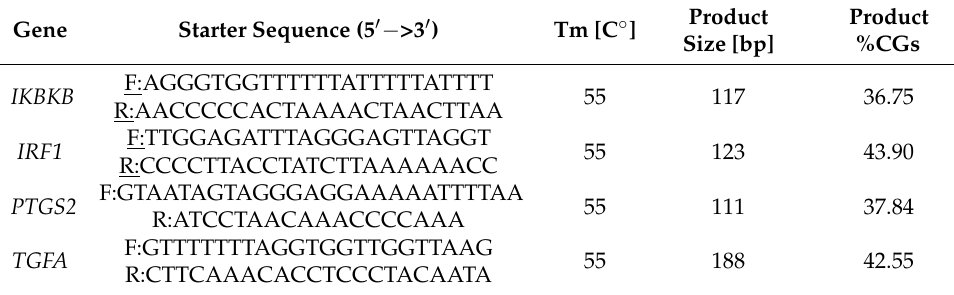
Table 2. The specification of primers used for the analysis of methylation levels in the promoter regions of the studied